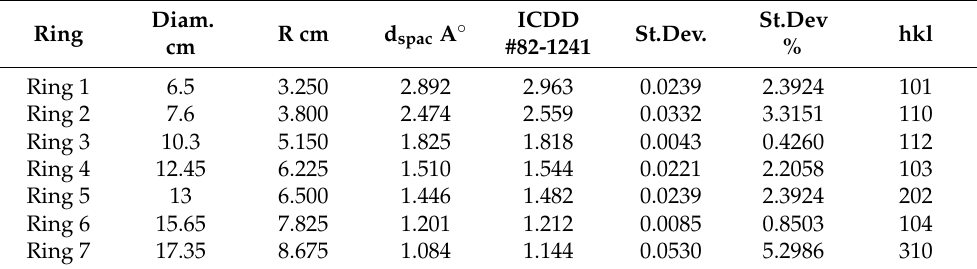
Figure 4. TEM image showing morphology of nanoparticles sintered at 1000 ◦ C ( a – c ), and electron diffraction pattern ( d ). Table 2. Experimental and theoretical d -value (interplanar spacing) of the phase identified as tetrago- nal Zirconia (Identification Card Number#